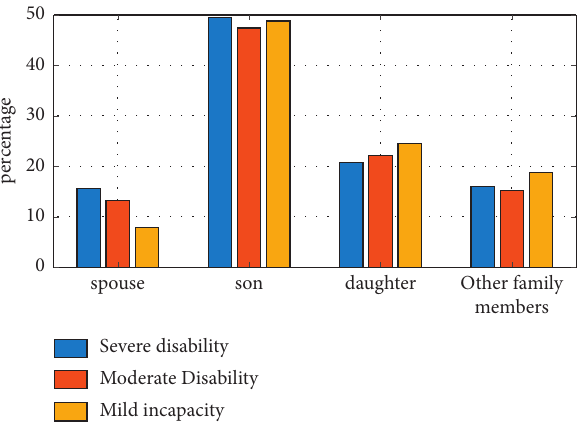
Figure 1: Differences in family caregiving time for older people with different levels of disability at